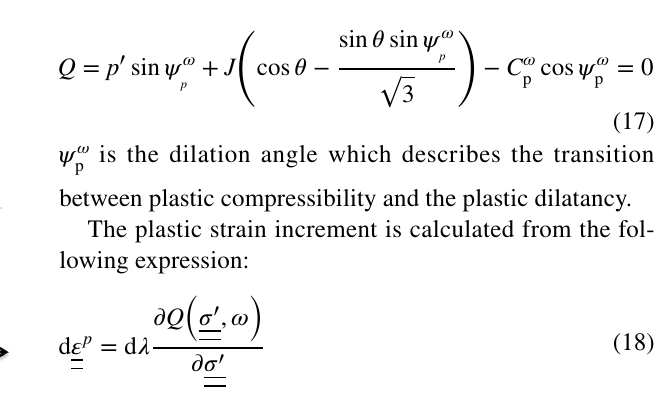
Sand formation condition prior to production